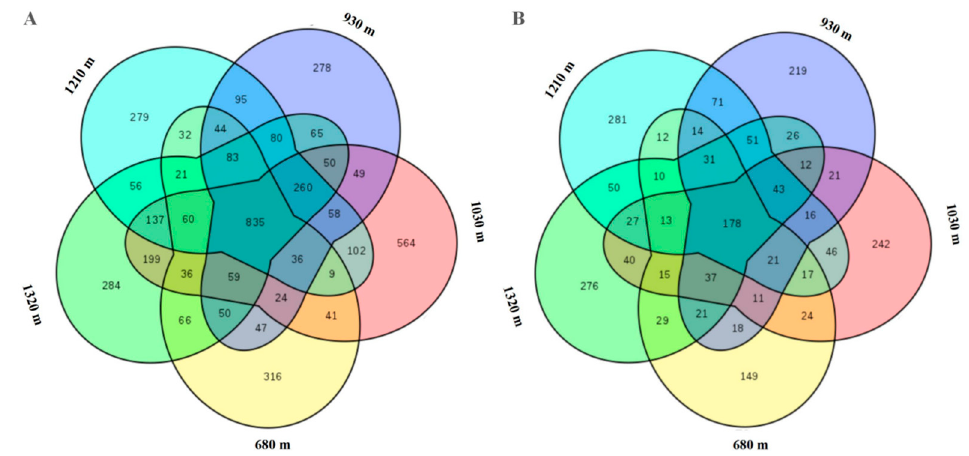
Figure 2. Venn diagrams of the bacterial ( A ) and fungal ( B ) OTUs in the C. arabica rhizospheric soil at different altitudes. The altitudes of the rhizospheric soil sample collection sites are presented in the figure (680, 930, 1030, 1210, and 1320 m).